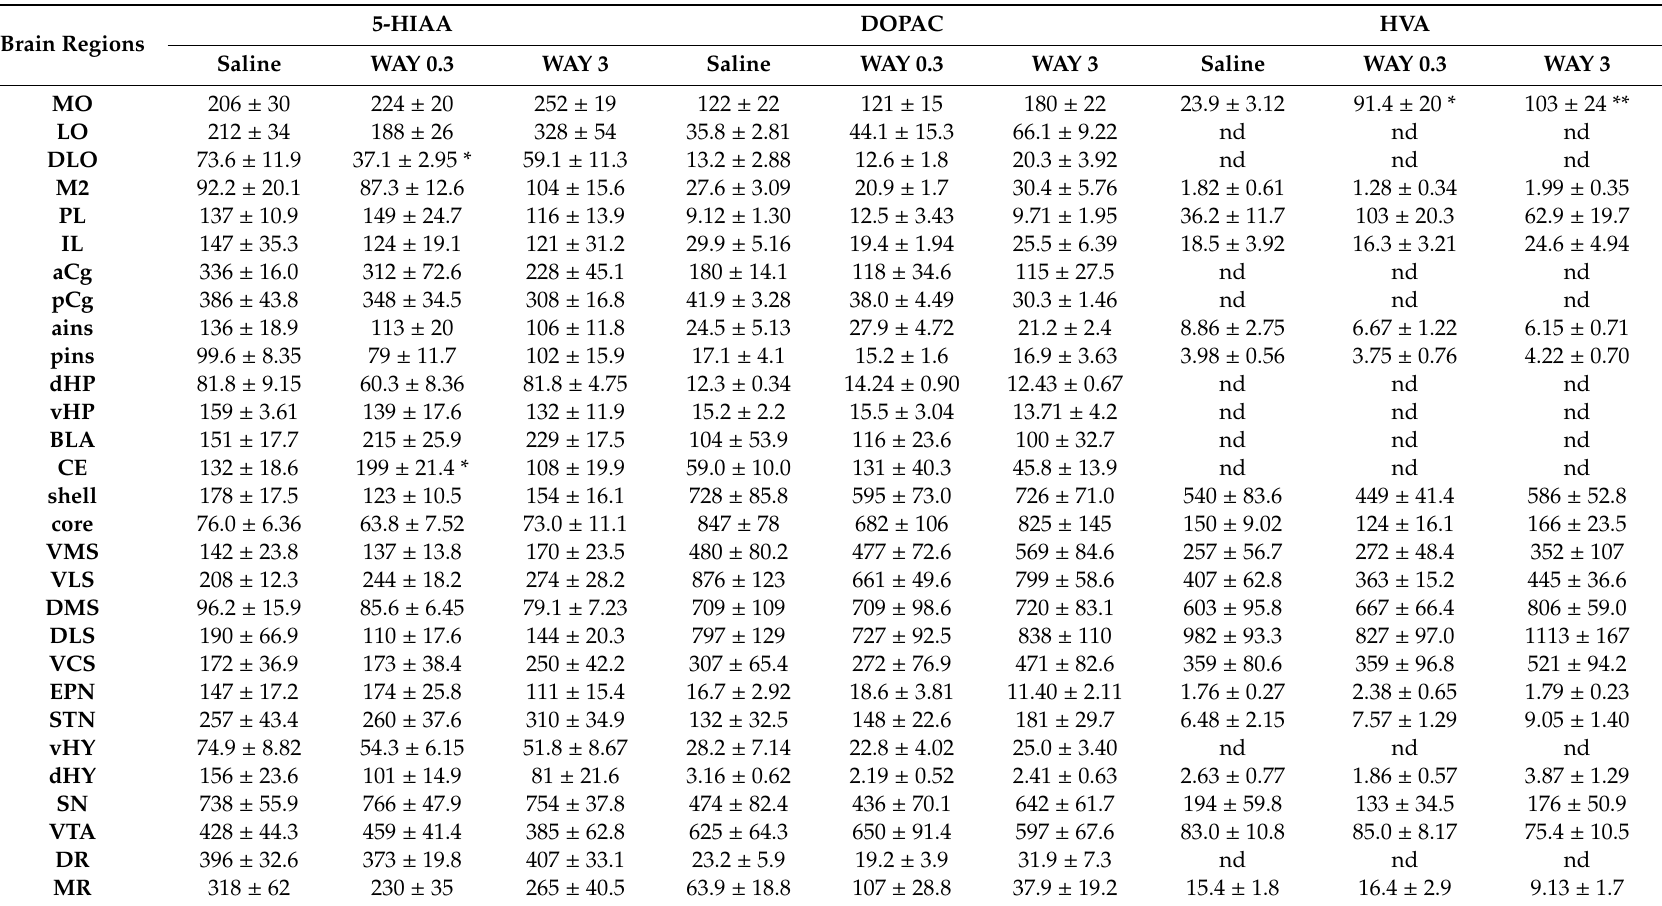
Table 1. Tissue content of 5-HIAA, DOPAC, and homovanillic acid (HVA) in brain regions of saline and WAY-163909-treated rats. Brain